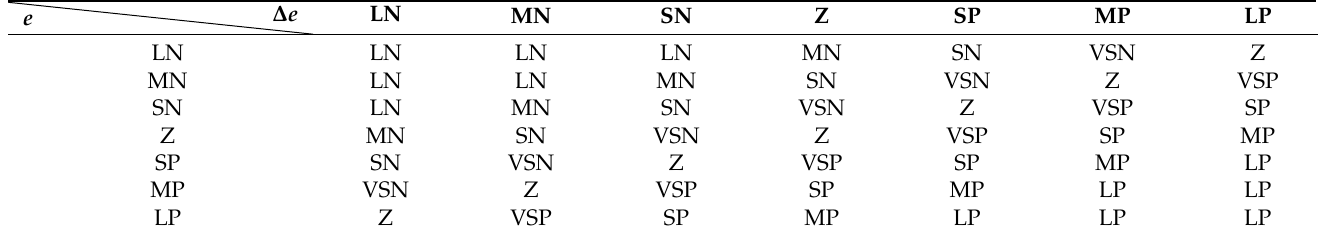
Table 2. In this table, the linguistic labels for the inputs and outputs are defined as: Table 2. Rules of